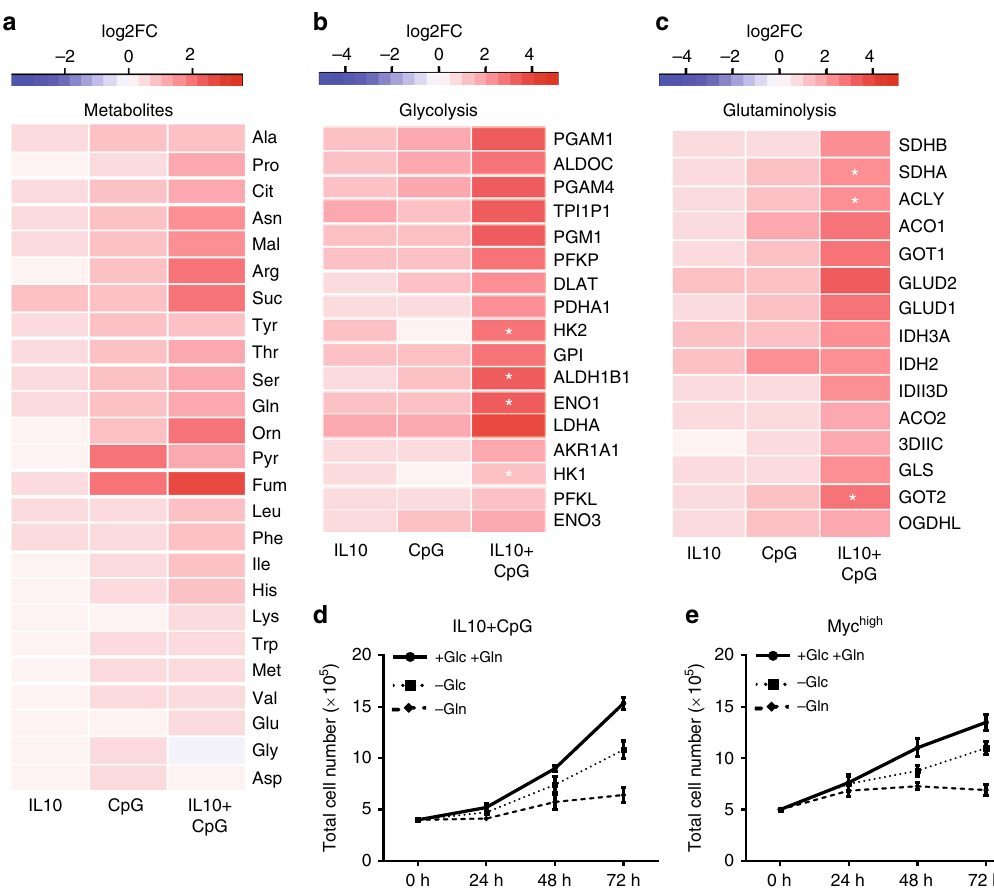
Fig. 1 Activation of cell metabolism and global gene expression by combined stimulation of P493-6 cells with IL10 and CpG. a Heat map of changes in intracellular metabolite concentrations depicted as Log2FC after IL10 and/or CpG stimulation of P493-6 MYC low cells in relation to unstimulated cells. Heat map of gene expression changes associated with b glycolysis (KEGG-term) and c glutaminolysis (KEGG-term), respectively, after IL10 and/or CpG stimulation of P493-6 MYC low cells presented as Log2FC. Mean of three independent experiments is shown in all heat maps. Effects on gene expression were analyzed by linear regression and p-values for the IL10:CpG interaction terms were calculated (adjusted by Benjamini – Hochberg). Positive synergistic interactions are marked with a star (* p < 0.05). Relative cell counts of d IL10 + CpG-stimulated P493-6 MYC low cells and e unstimulated P493-6 MYC high cells grown in media with and without either glucose ( – Glc) or glutamine ( – Gln). Mean ± SD of three independent experiments are